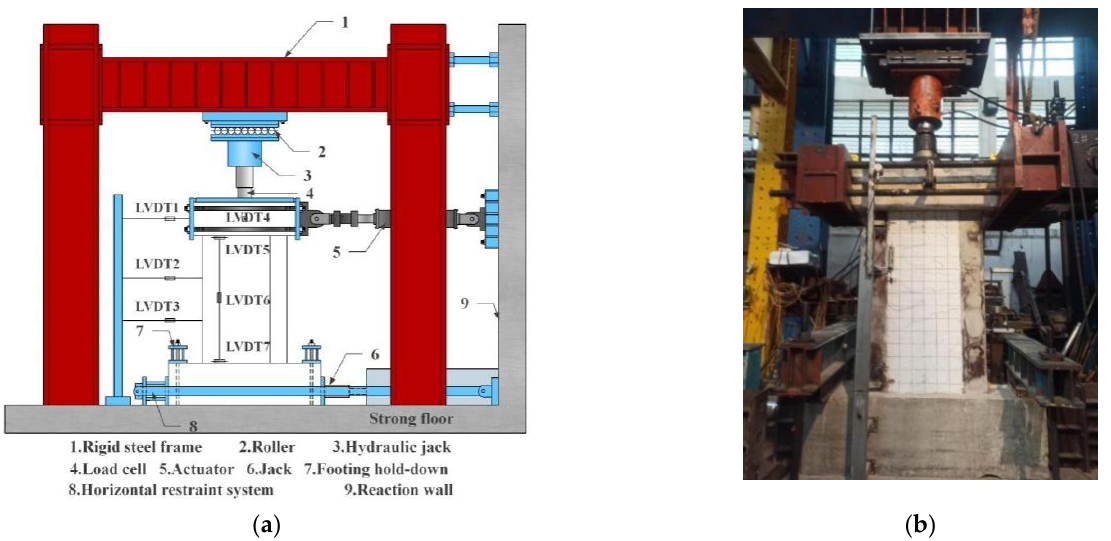
Figure 5. Test setup. ( a ) Schematic diagram of test setup; ( b ) Specimen installation site.